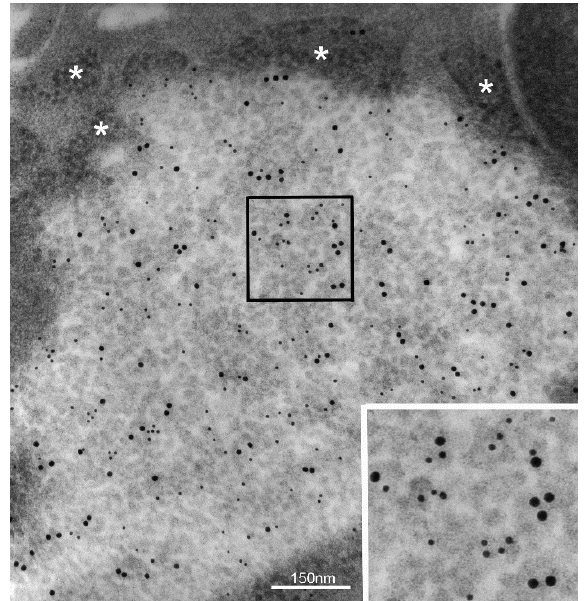
Figure 4. H. pylori oncogenic protein CagA concentrates inside PaCS. PaCS from an H. pylori -infected human gastric epithelium (enlarged in the inset; 100,000×) shows selective immunogold reactivity for the bacterial oncogenic protein CagA (small gold particles) in addition to 19S proteasome (large gold particles). Note ribosomes (asterisks) in the cytoplasm surrounding PaCS.